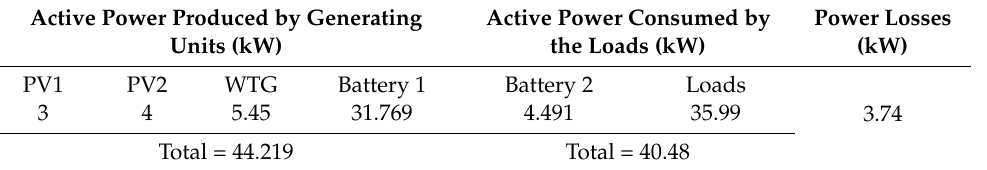
Table 3. The power production and the power during island mode.